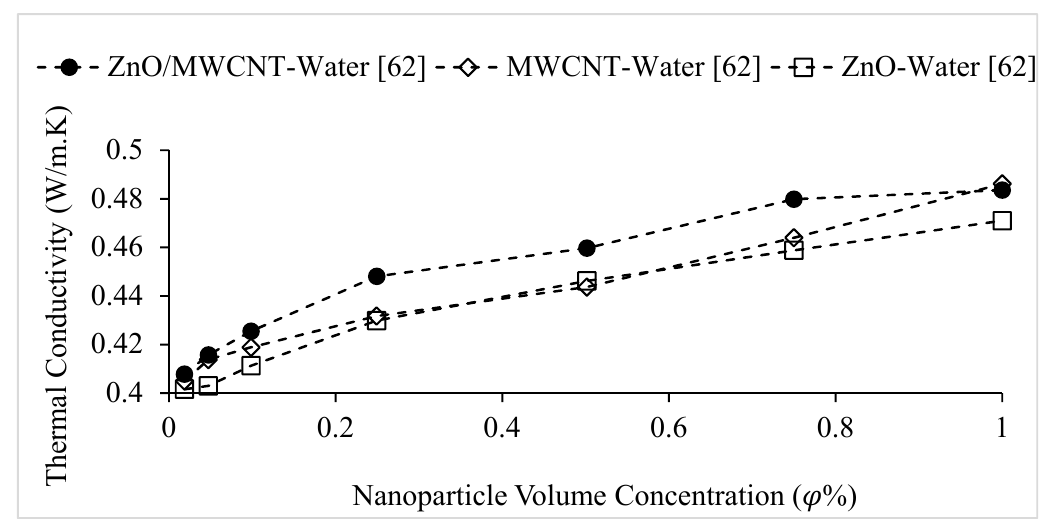
Figure 26. Comparison of the thermal conductivity of hybrid nanofluid to nanofluids containing single types of nanoparticles as a function of nanoparticle volume concentration, 𝜑, in 50–50 Ethylene Glycol/water base liquid, at 40 °C.